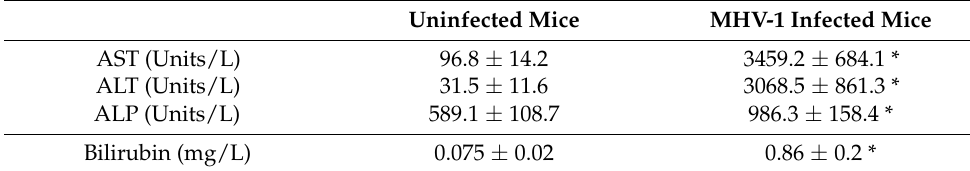
Table 1. Liver enzymes of mice exposed to